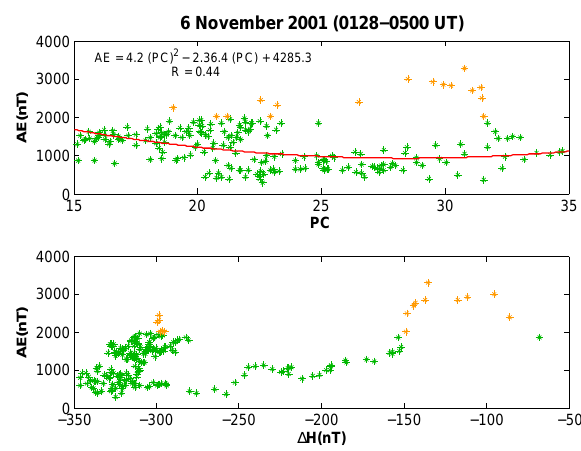
Fig. 14. Illustrates correlations between PC and AE (upper panel) and 1H ABG and AE index (lower panel) during “ T 2” period (01:28–05:00 UT) of the 6 November 2001 storm event. Green colour represents correlations for AE values lying within 2000nT and orange colour depicts correlations for AE values more than